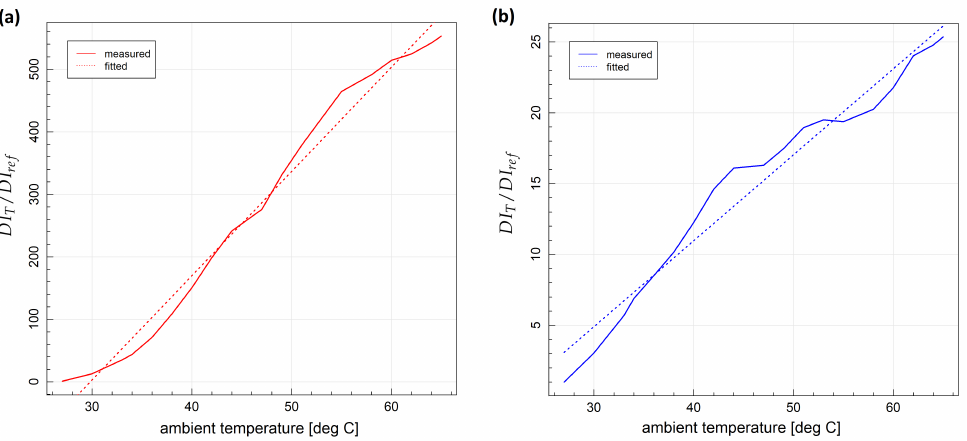
Figure 7. Dependence of relative change of damage indices on temperature for specimen no. 1: ( a ) corr damage index; ( b ) divAmp damage